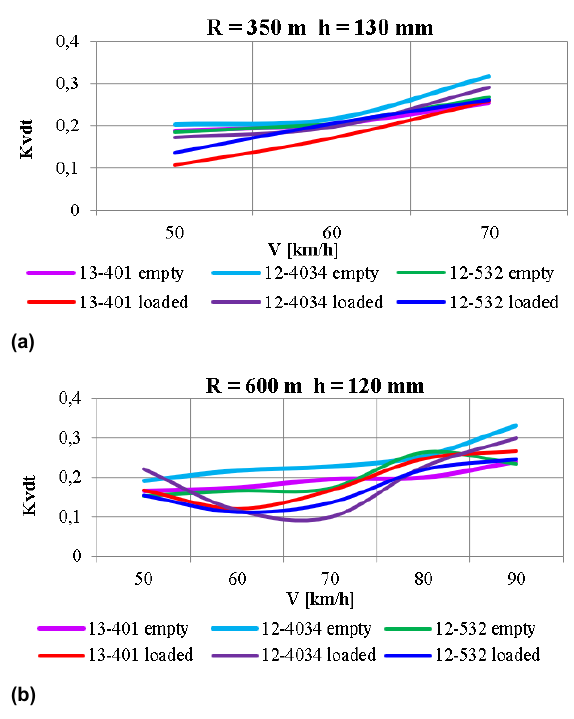
Figure 13. Variation of the coefficient of vertical dynamics of the track by the forces of the wheels and rails interaction with the motion speed: (a) R=350 m curve; (b) R=600 m curve